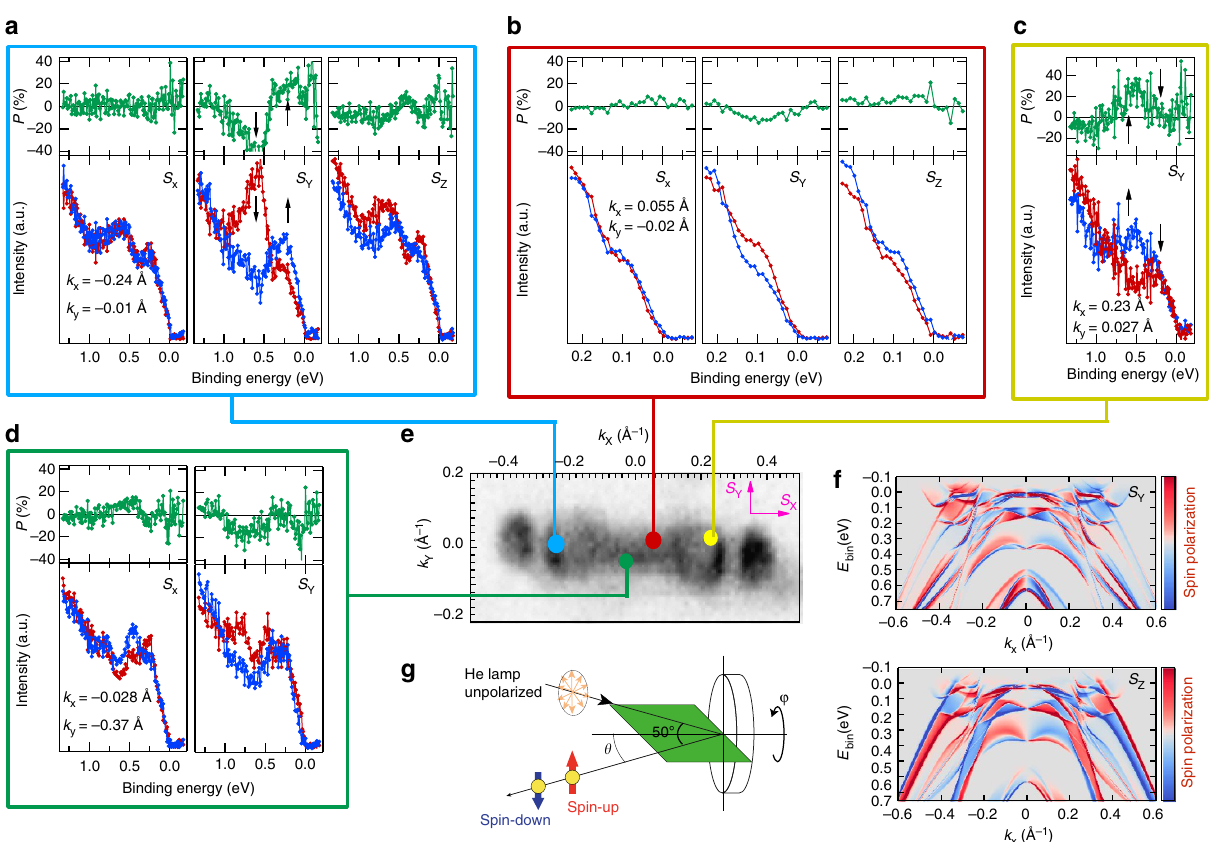
Figure 4 | Experimental and theoretical spin polarized band structure of large SOC and non-centro-symmetric WTe 2 . ( a – d ) Measured spin-resolved ARPES spectra (red and blue curves) and spin polarization (green curves) at four distinct k points as indicated in e ; ( e ) experimental Fermi surface with the corresponding spin measurement positions; ( f ) calculated band structure along k x direction, upper/lower panel shows S y / S z spin orientation. The colour scales represent the degree of spin polarization; red, blue and white refer to up, down and no-spin polarization, respectively; ( g ) experimental geometry of spin-resolved ARPES setup. In a , S y , the down-spin spectrum (red curve) has a larger peak at 0.6eV (down arrow) and the up-spin spectrum (blue curve) has a larger peak at 0.2eV (up arrow), whereas at c , on the contrary, the up-spin spectrum has a dominating peak at 0.6eVand the down-spin spectrum has a dominating peak at 0.2eV, supporting time-reversal